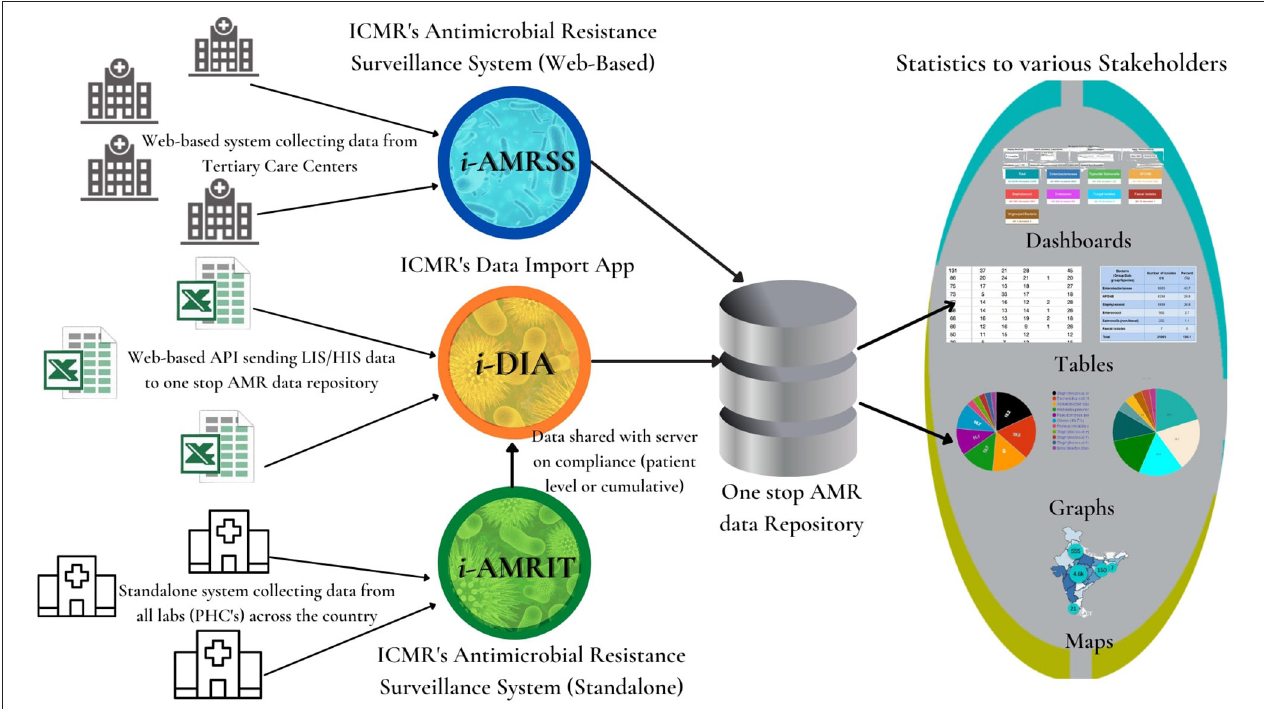
FIGURE 1 | Ensemble of tools for strengthening the surveillance of antimicrobial resistance in India using integrative technologies.